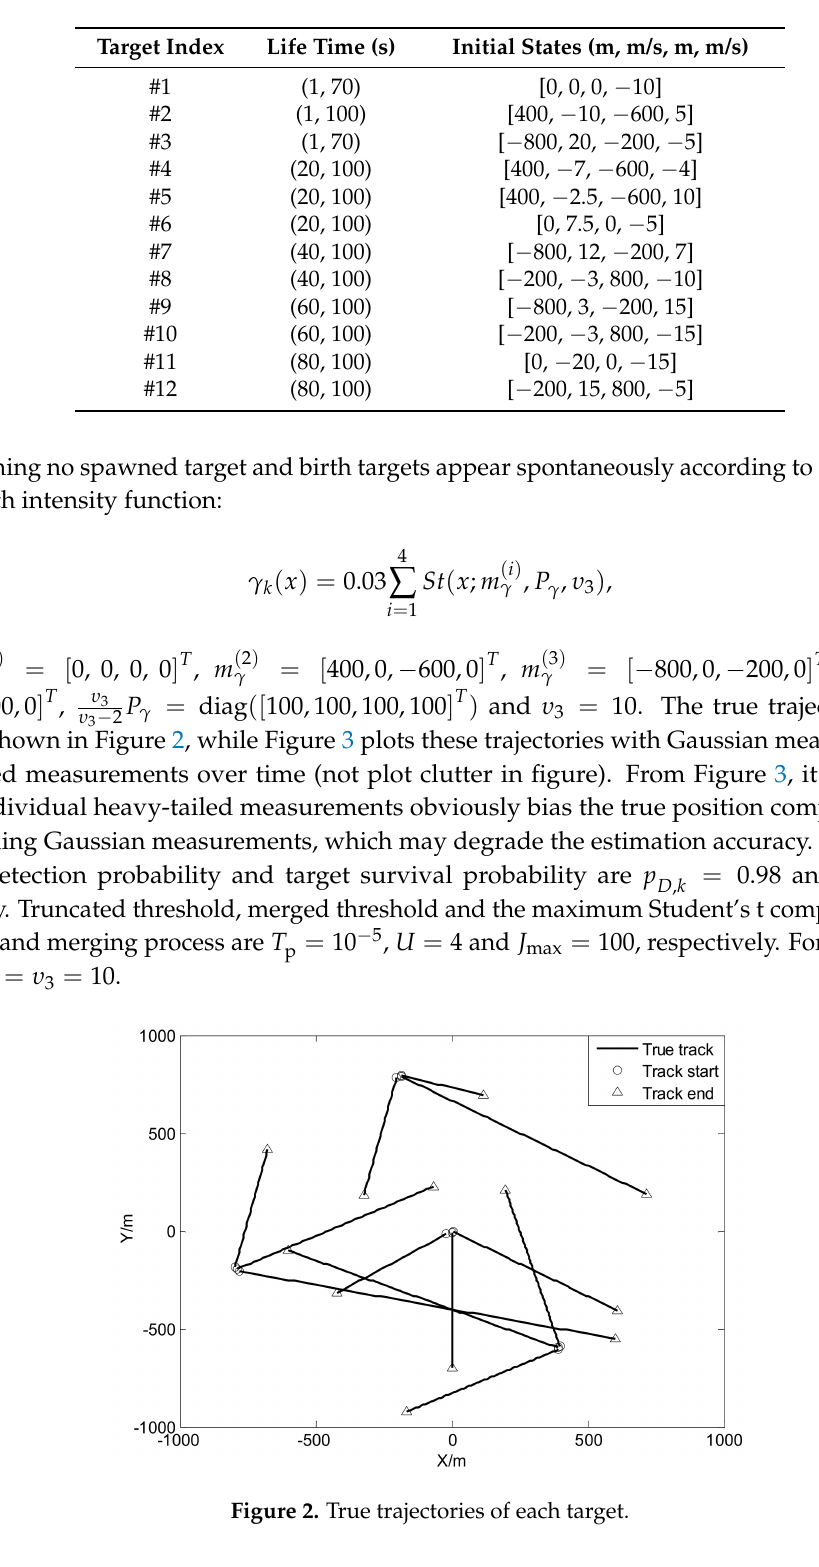
Table 1. A list of initial target states.